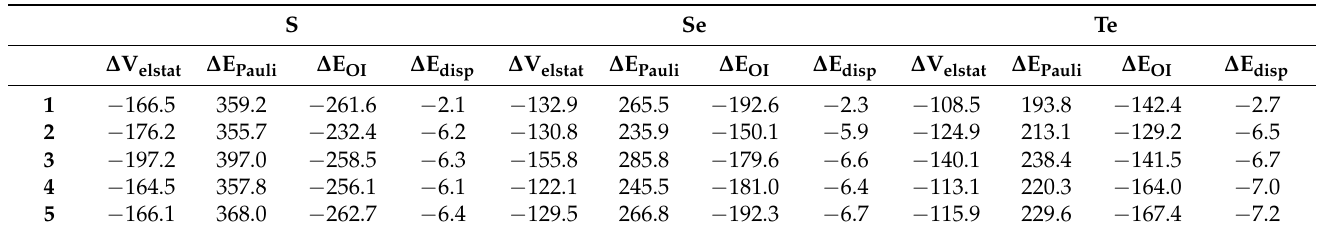
Results highlighted how the decrease of total orbital interactions ( ∆ E OI ), as we moved down in the group, was the main factor that caused a diminished ∆ E int . Table 4. EDA for the investigated compounds (energies in kcal mol − 1 ). Level of theory BLYP-QZ.